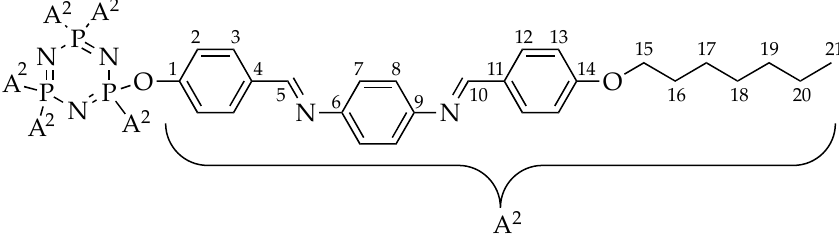
Figure 2. Structure of compound 4a with complete atomic numbering.